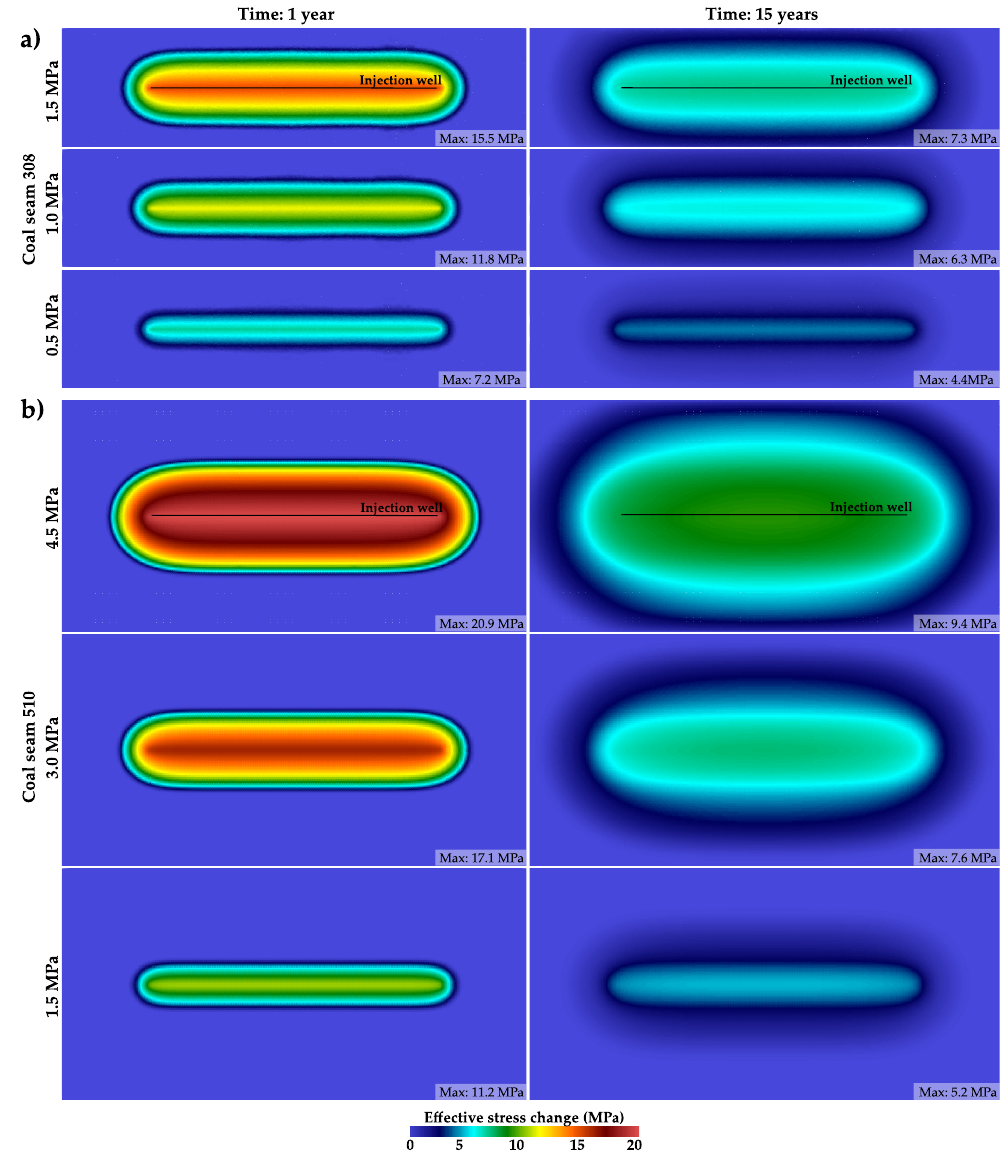
Figure 6. Effective stress changes in coal seams ( a ) 308 and ( b ) 510 for the investigated scenarios at simulation times of 1 year (operational state) and 15 years (post-operational